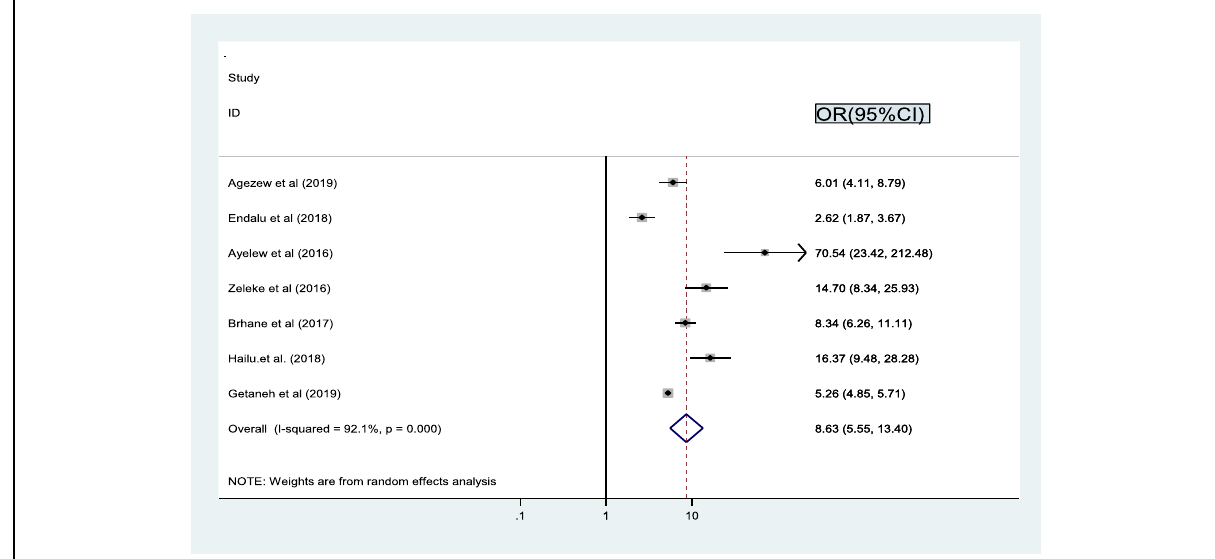
Fig. 3 Pooled odd ratio between adherence and treatment